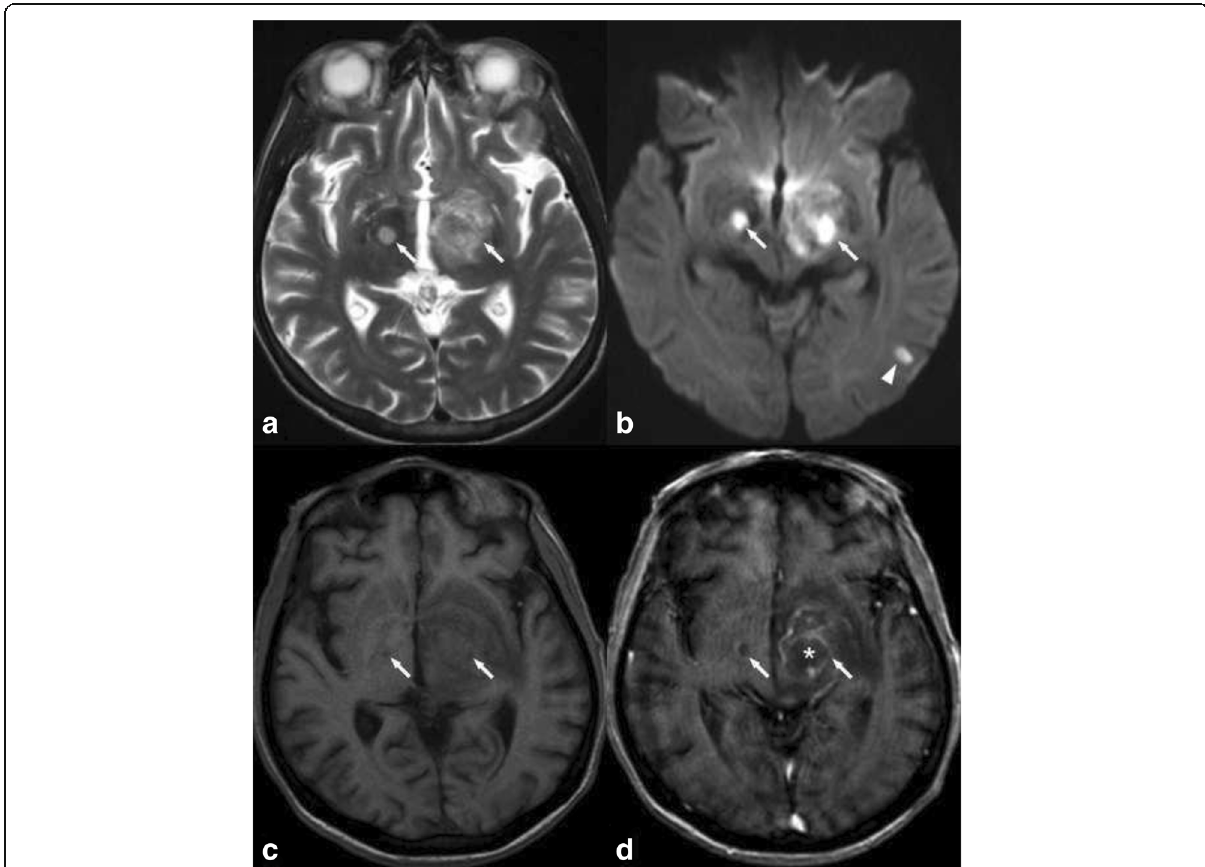
Fig. 3 T2WI and DWI hyperintense lesions in both thalami (arrows in a and b ). The lesions are hypointense on T1, and there is a non-enhancing central region corresponding to an area of necrosis (* in d ). This pattern of enhancement suggests lymphoma in immunocompromised